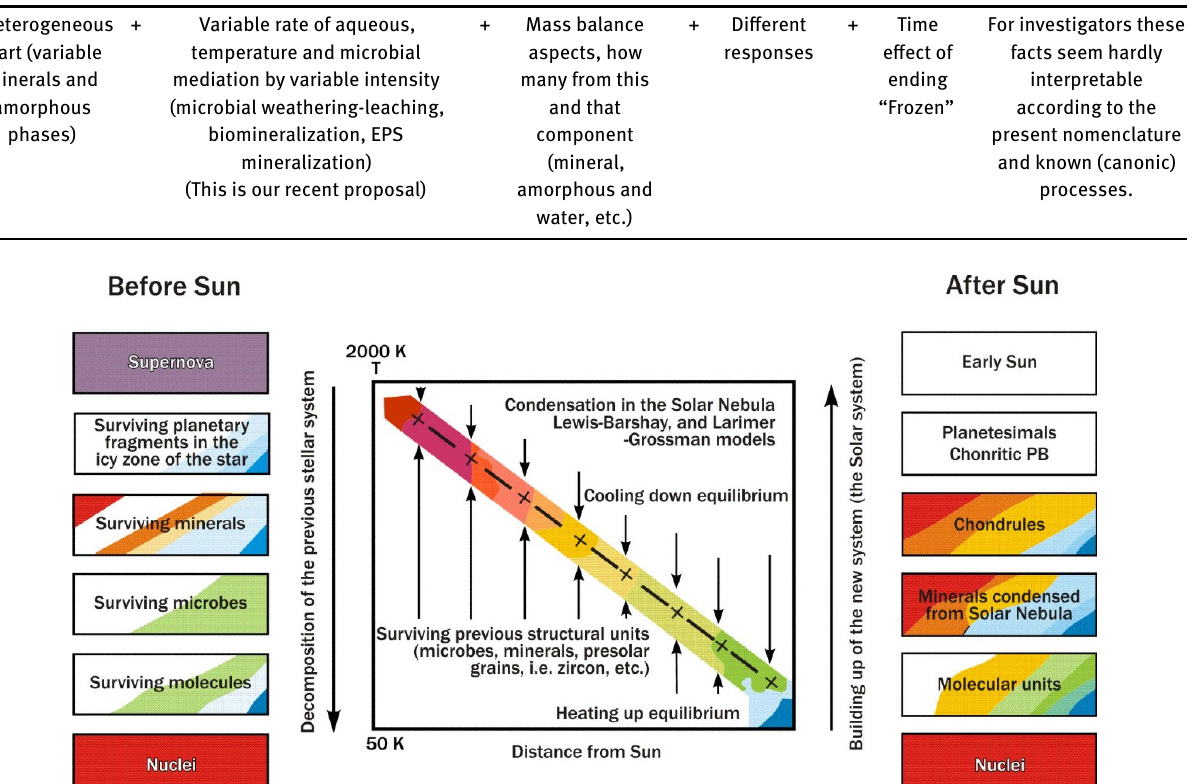
Parallel to the microbially mediated processes, water (or fluid) abiogenic processes may also produce phyllosili- cates, although other types. Dehydration and thermal meta- morphism by diffusion are strongly dependent on tempera- ture, so these are the last, gradually increasing transforma- tion